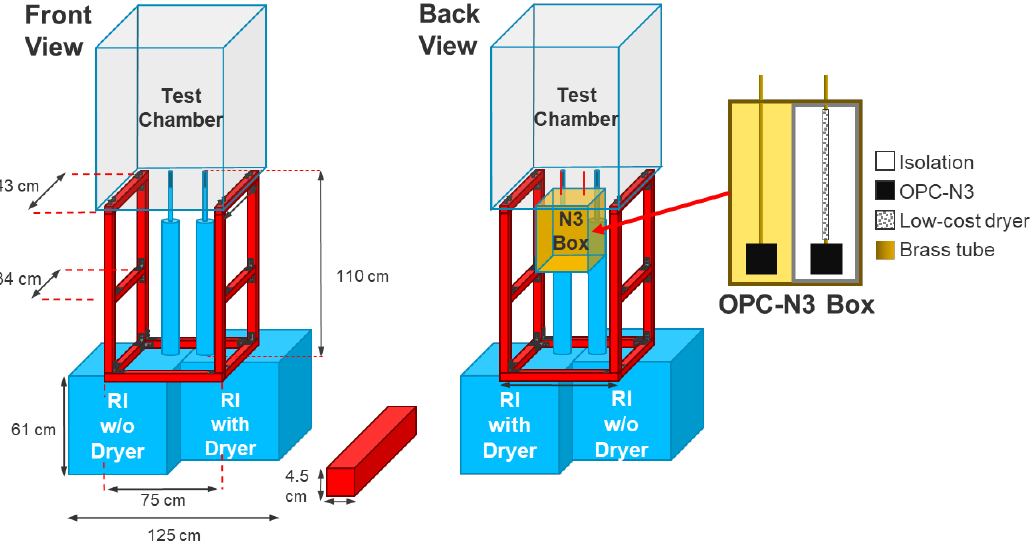
Figure 3. Experimental setup for laboratory measurements.